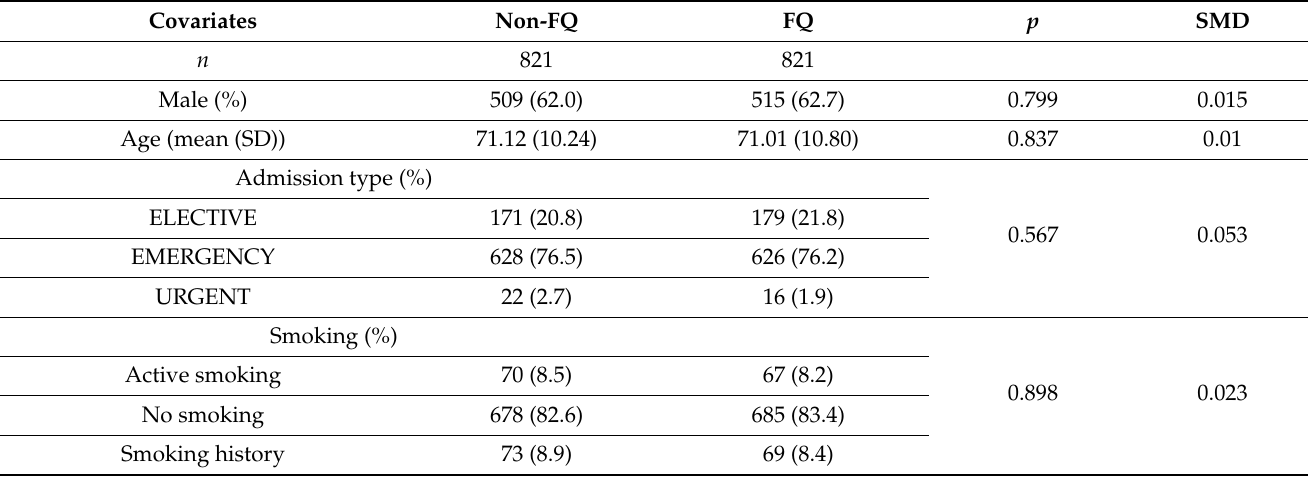
Table 2. Comparison of covariates in matched